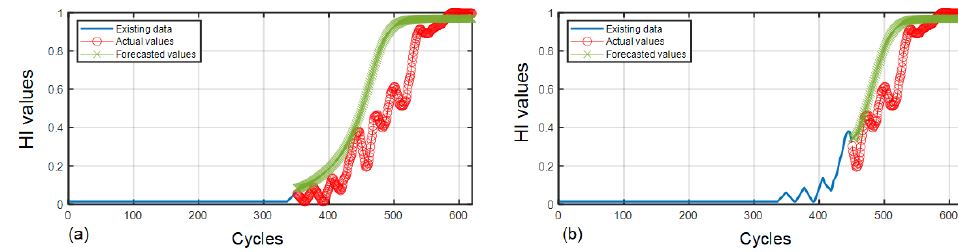
Figure 16. LSTM-RNN-based RLU prediction results of concrete beam C: ( a ) at cycle 350; ( b ) at cycle 450.